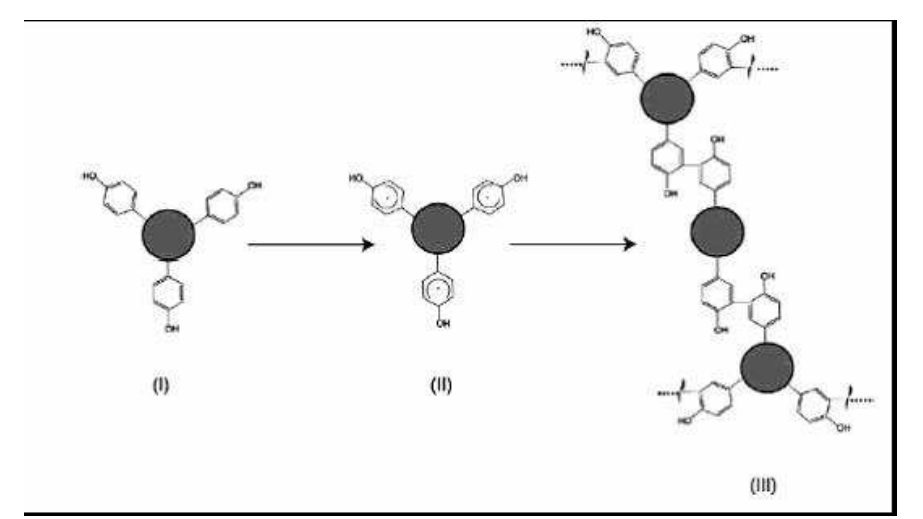
Figure 11. Principle of peroxidase based assay. In the presence of peroxidase, free radicals are formed allowing self assembly ( Reprinted from [27] with permission from ACS ).